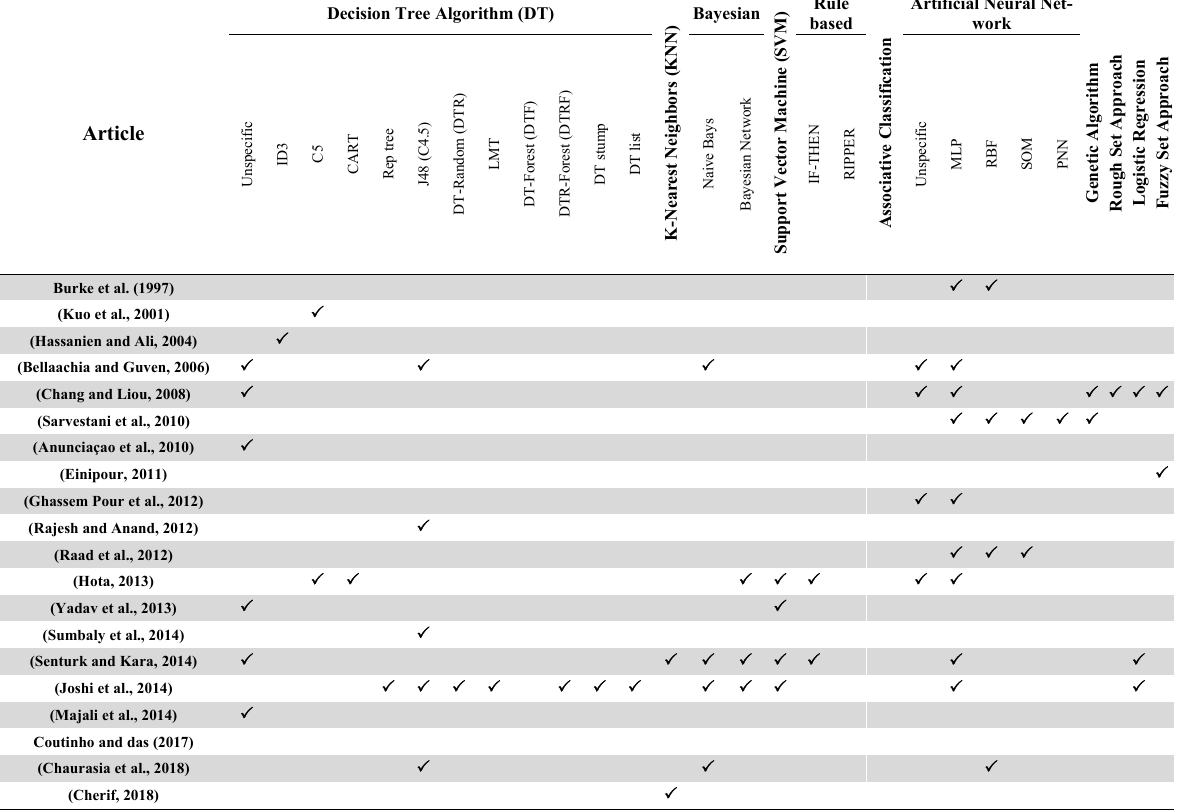
The overall review of the classification